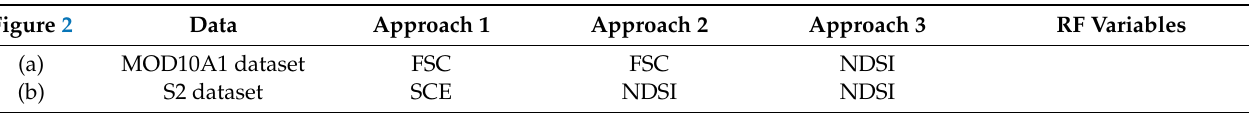
Table 1. Description of the different input datasets and random forests selected in the three differ- ent approaches compared in this study. Fractional Snow Cover (FSC), Snow Cover Extent (SCE), Normalized Difference Snow Index (NDSI).